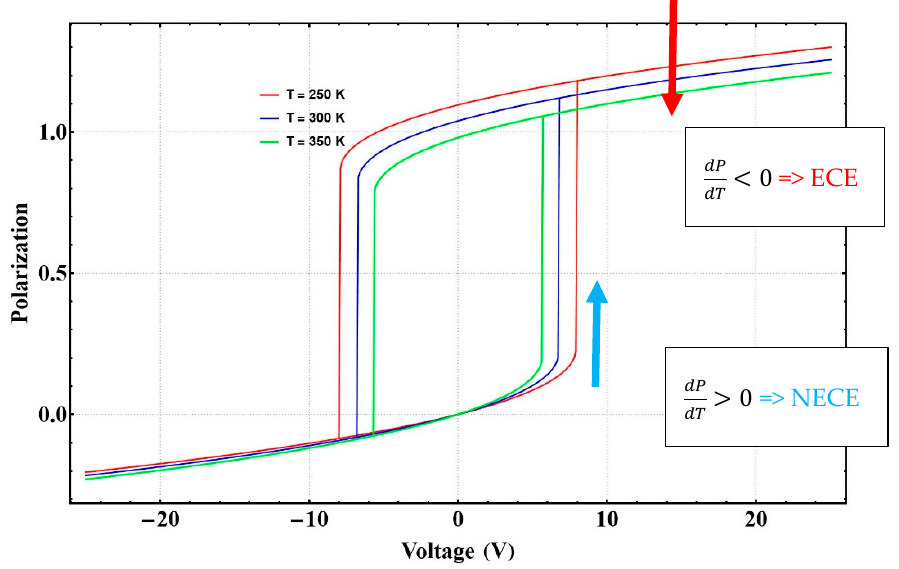
Figure 8. The theoretical polarization–voltage loops at different temperatures, deduced with classical thermodynamic treatment.